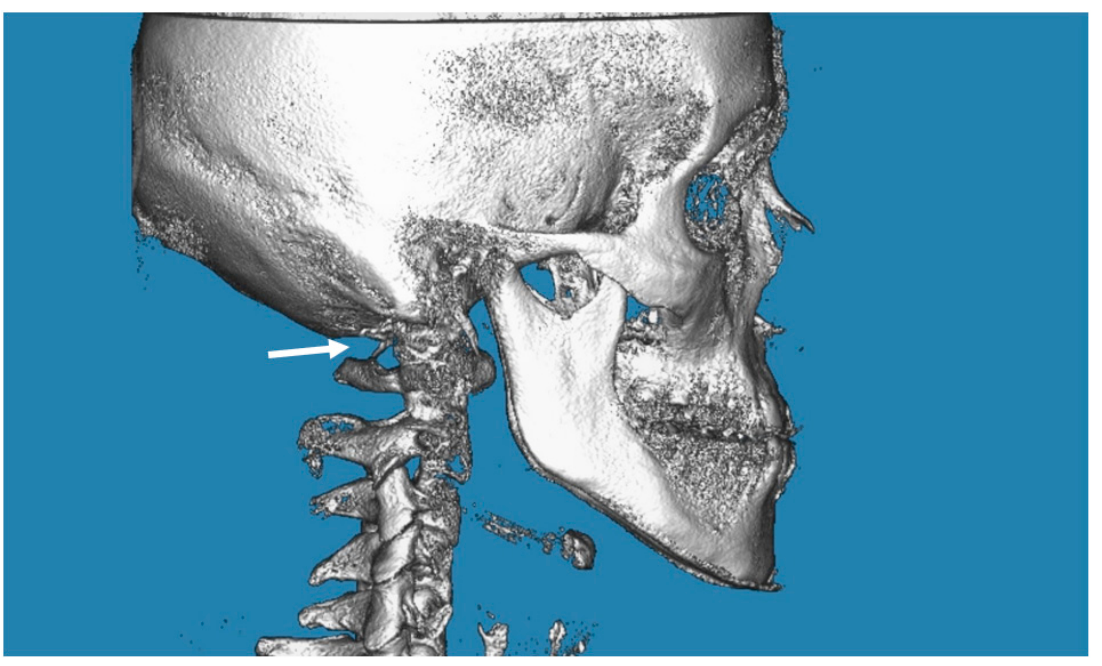
Figure 1. CBCT image of the complete PP on the right (indicated by the arrow). The image is taken from the “G. D’Annunzio” University archives.